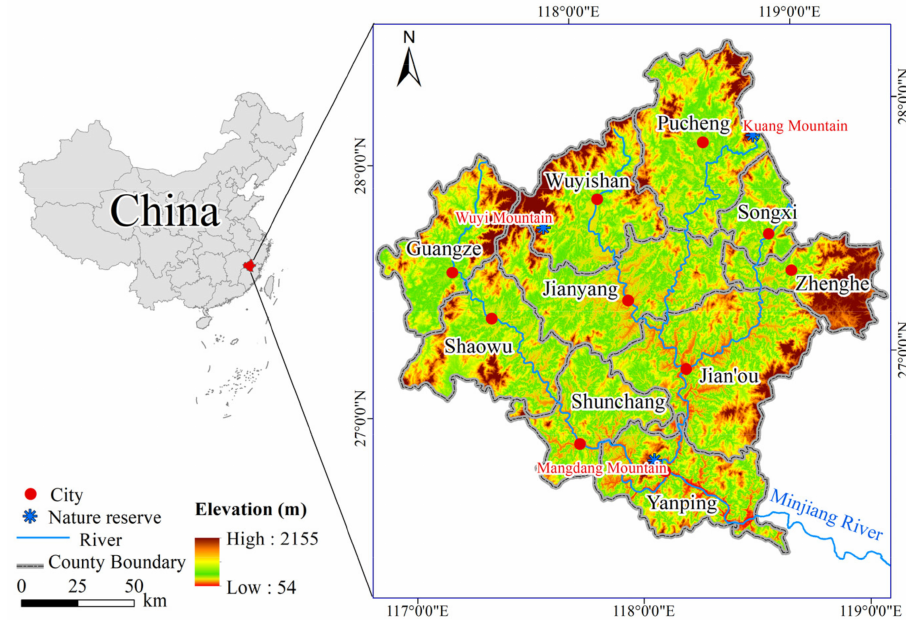
Figure 1. Location of the study